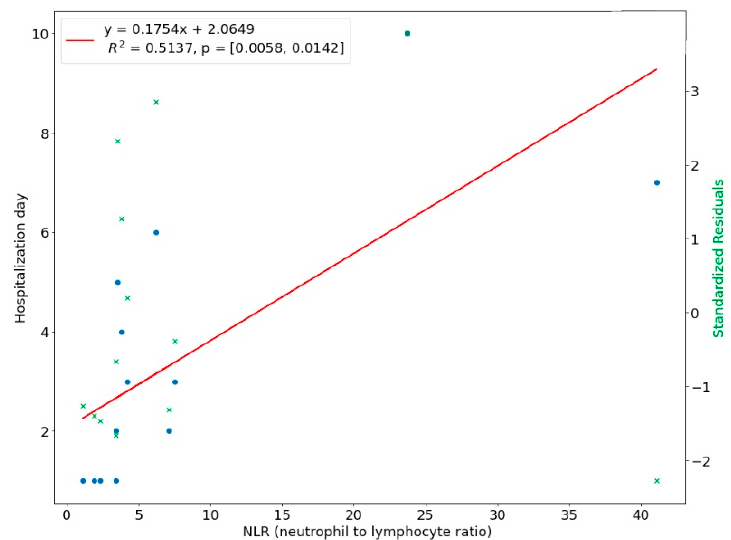
Figure 8. Correlation of NLR with length of hospital stay in upper face odontogenic infections.